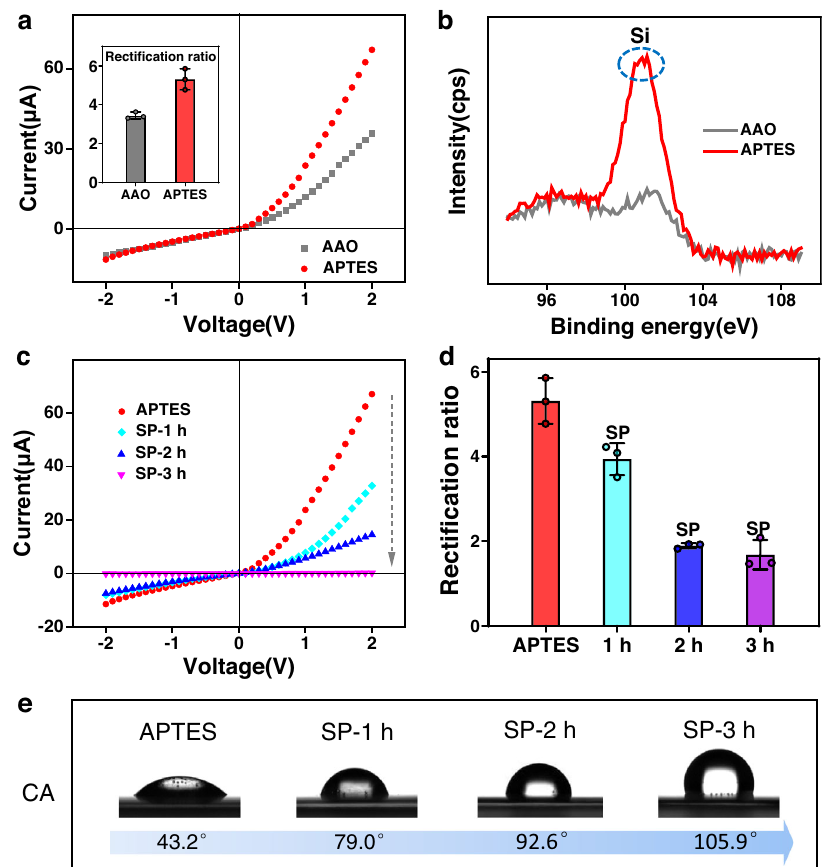
Fig. 2 | Fabrication and characterization ofSP/AAO nanochannels. a I – V curves and ( b ) XPS features of the AAO nanochannels before and after APTES treatment. c I – V curves, ( d ) recti fi cation ratios, and ( e ) CA measurements of APTES-treated nanochannelsbeforeandaftermodi fi cationwithSP.Errorbarsintheinsetofaand in d denote the standard deviation from three different samples. AAO anodic